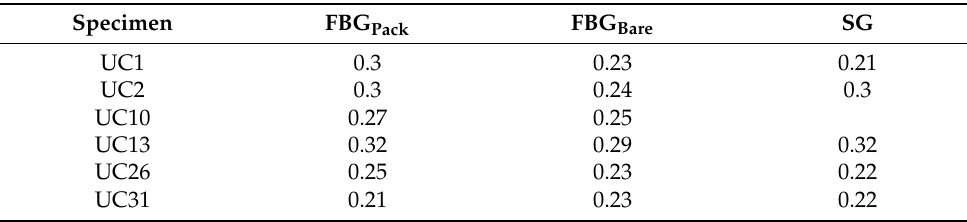
Table 4. Poisson’s ratio of each specimen computed from the sensors.